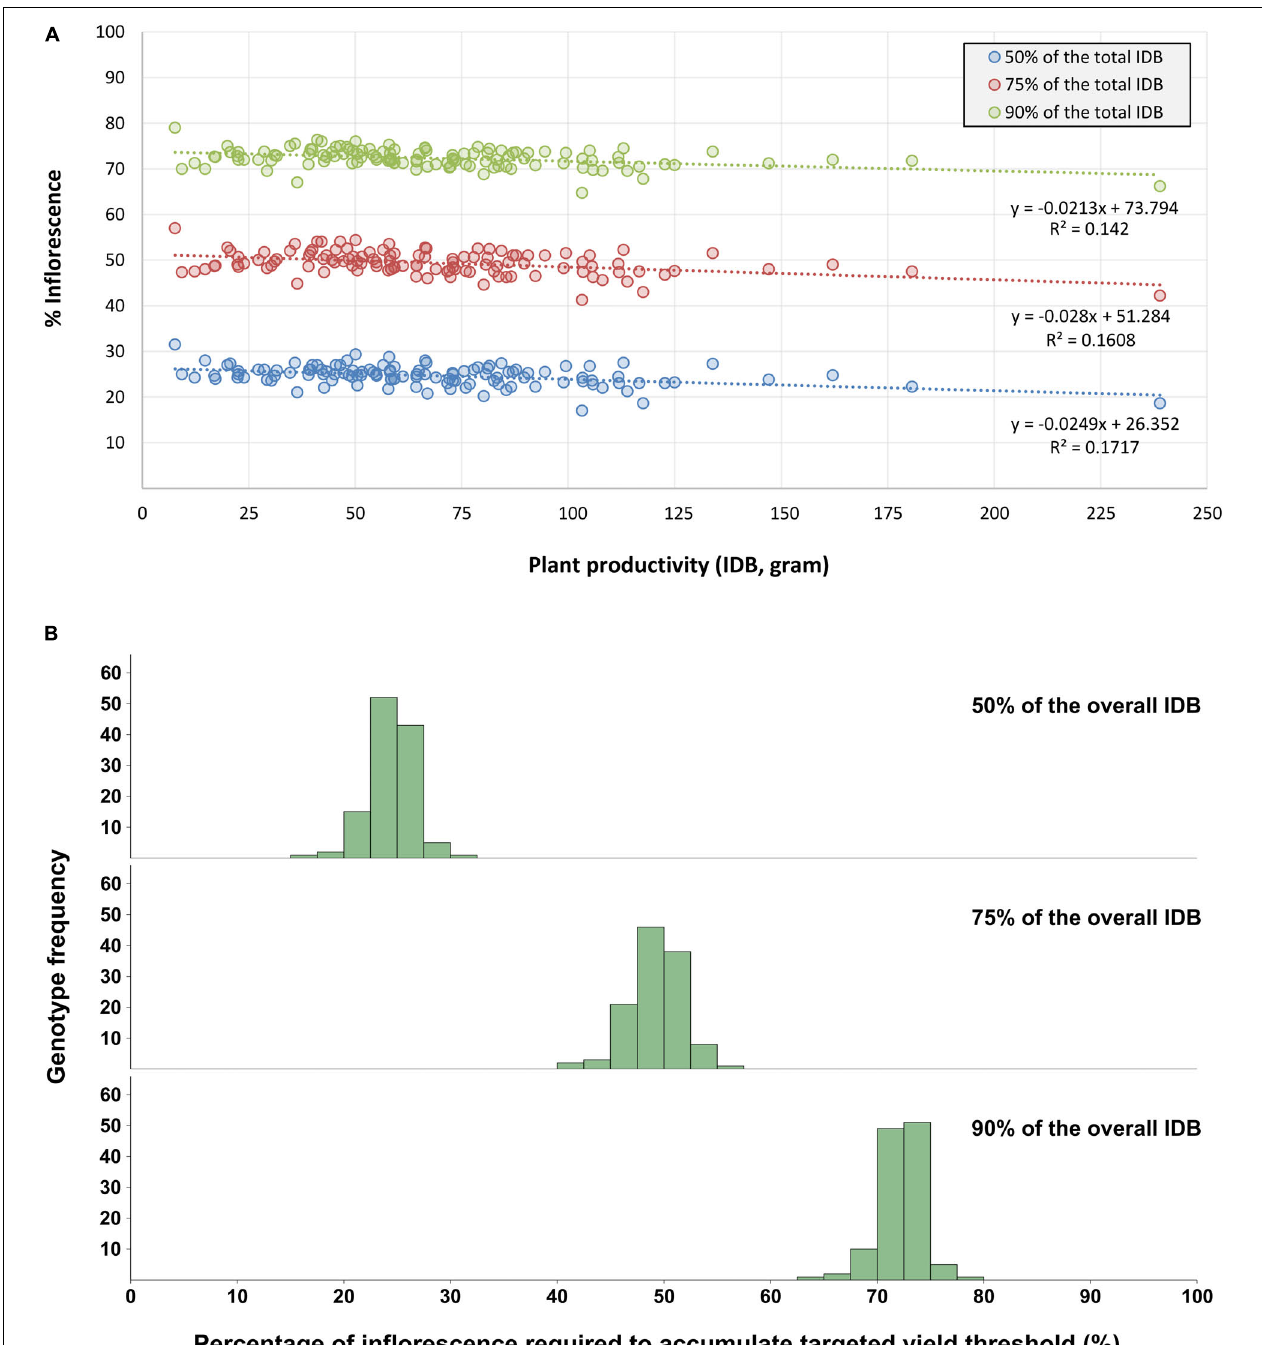
FIGURE 8 | Percentage of inflorescences required for the accumulation of 50%, 75% and 90% of the overall IDB. The presented data refers to the proportion between the larger inflorescences quantity (required to accumulate the targeted yield threshold) and the overall inflorescences quantity within each plant. (A) Illustrates the percentage dispersal across all genotypes for each of the targeted yield thresholds. Linear regression trendlines and their corresponding datapoints are marked with the same color, (B) Presents the frequency distribution of all examined genotypes across the three targeted yield thresholds.